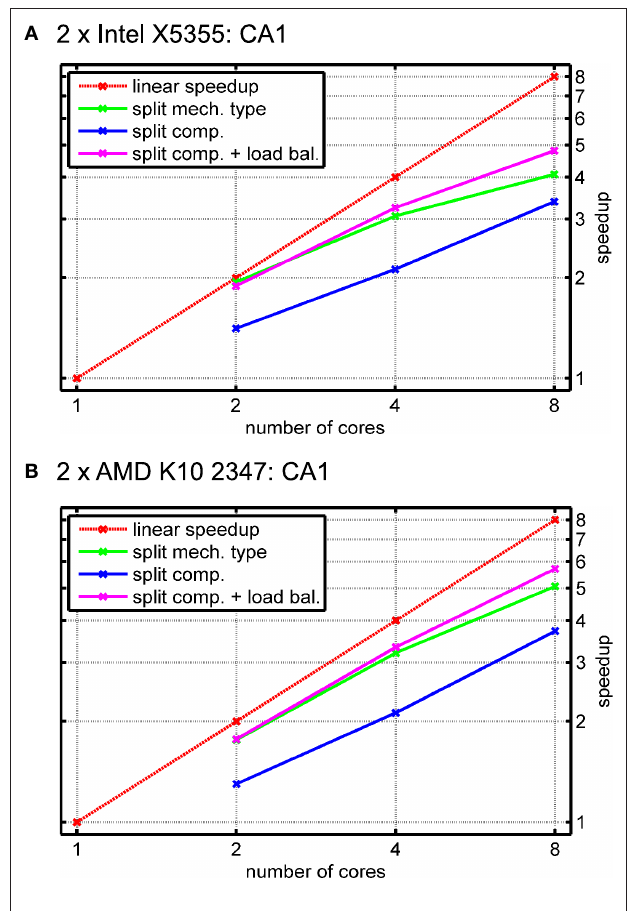
FIGURE 12 | Simulation of a CA1 pyramidal cell with 600 compartments for 900 ms with a time step length of Δ t = 0.025 ms (see Migliore et al., 1999). The cell is split into two equally large pieces; distal dendritic compartments do not use active channels, thus giving a heterogeneous mechanism distribution across the cell. (A) Speedup results on the Intel test system (see Figure 11A ). Red line: linear speedup; green: measured speedups of mechanism type level parallelization ( Figure 5 ); blue: compartment level parallelization ( Figure 7 ) without load-balancing for taking into account heterogeneous mechanism distribution across cell; magenta: compartment level parallelization with load-balancing. (B) Same as (A) on the AMD test system ( Figure 11C